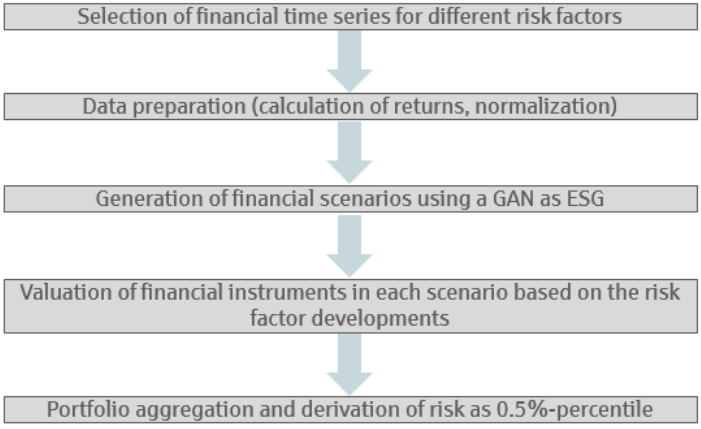
Figure 6. Workflow of a GAN-based internal